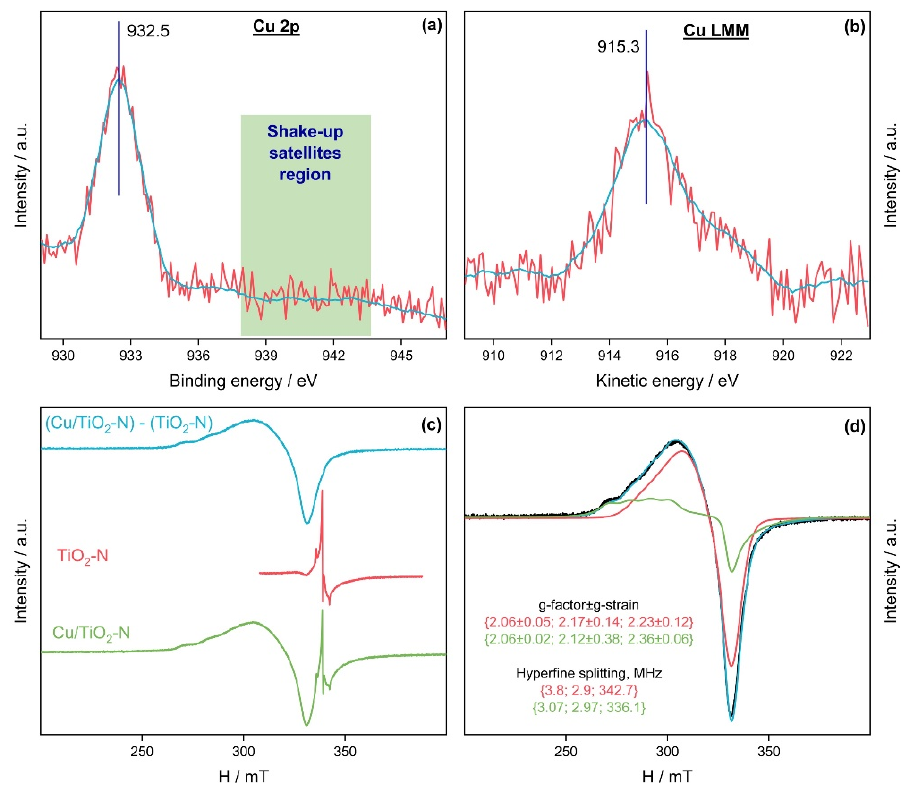
Figure 10. Photoelectron Cu 2p ( a ) and Cu LMM ( b ) spectral regions for the synthesized Cu/TiO 2 -N sample; experimental ( c ) and simulated ( d ) EPR spectra of Cu/TiO 2 -N.